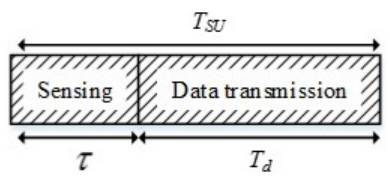
Figure 2. Secondary user (SU) frame structure.